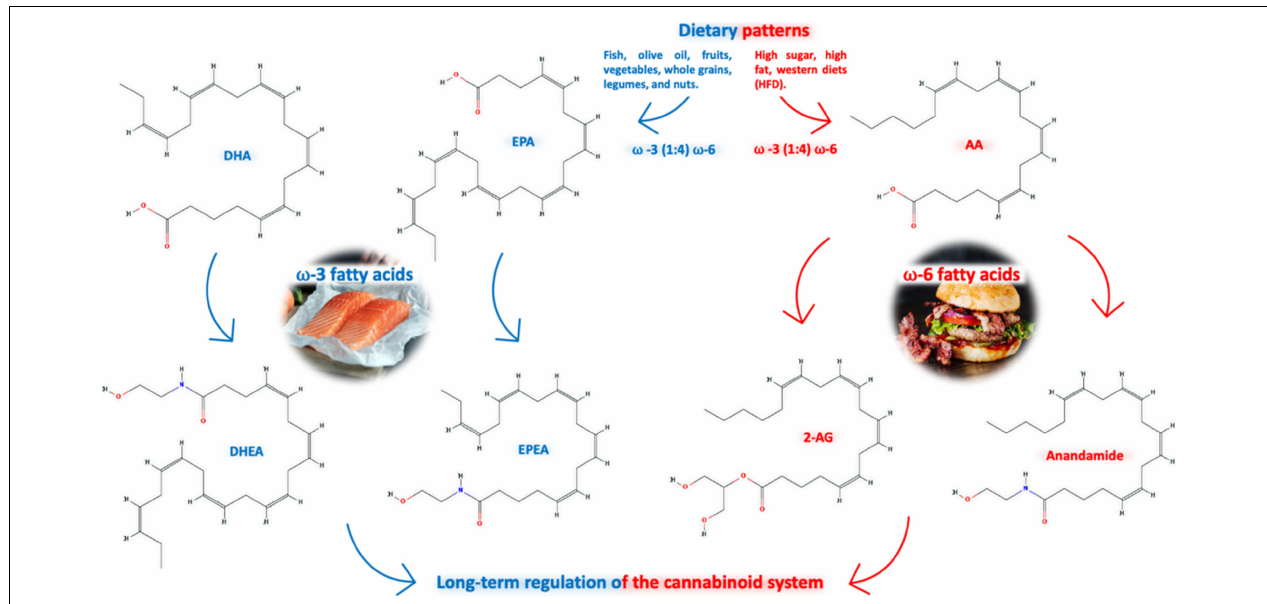
FIGURE 2 | Dietary patterns, as the Mediterranean (n-3 series enriched) are linked to better physiological parameters decreasing the outcome of several types of diseases, which consists of unsaturated lipids from fish (and olive oil, fruits, vegetables, whole grains and legumes/nuts), impacting on the levels of eCBs; they are influenced by the content of n-3 series derived from alpha-linolenic acid (ALA, 18:3n-3) and n-6 series (enriched in Western diet) derived from linoleic acid (LA, 18:2n-6), essential polyunsaturated fatty acids (PUFA); both AEA and 2-AG are derived from AA of the n-6 family, while N-docosahexaenoyl-ethanolamine (DHEA) and N-eicosapentaenoyl-ethanolamine (EPEA), are derived from the n-3 PUFAs docosahexaenoic acid (DHA) and eicosapentanoic acid